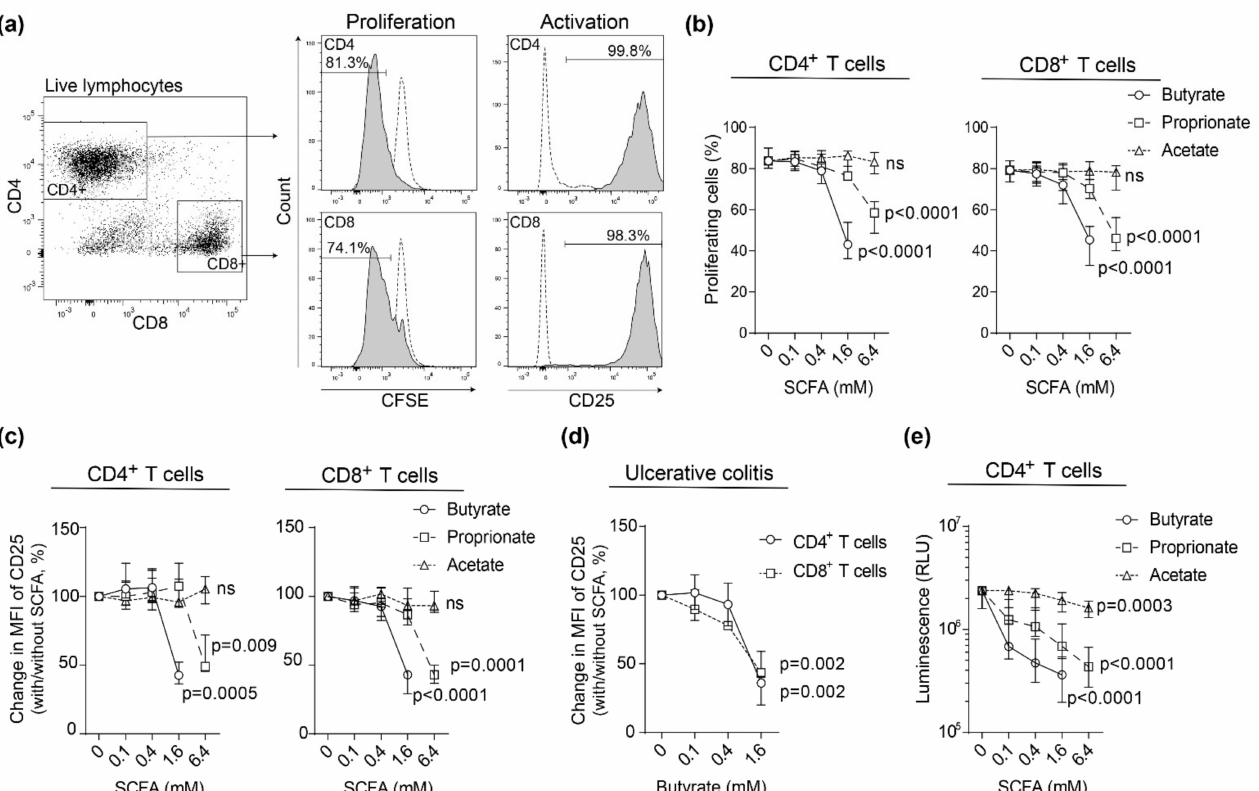
Figure 1. Effects of short-chain fatty acid (SCFA) on blood T cell proliferation and activation. Carboxyfluorescein succin- imidyl ester (CFSE) labeled peripheral blood mononuclear cells (PBMCs) were stimulated with anti-CD3 and anti-CD28 with increasing concentrations of butyrate (0–1.6 mM), proprionate (0–6.4 mM) or acetate (0–6.4 mM) for 72 h and analyzed by flow cytometry. ( a ) Left, gating strategy using a healthy subject for CD4 + and CD8 + T cells from live lymphocytes. Right, gating strategy for proliferating cells (CFSE intensity) and activated cells (CD25). Dotted line shows cells cultured without anti-CD3 and anti-CD28. ( b ) The frequency of proliferating T cells and ( c ) change in median fluorescent intensity (MFI) of CD25 in stimulated T cells from healthy subjects (n = 9). ( d ) Change in CD25 MFI in stimulated T cells from ulcerative colitis (UC) patients with active disease ( n = 7). ( e ) Histone deacetylase (HDAC) I and II activity in purified CD4 + T cells stimulated with anti-CD3 and anti-CD28 for 48h followed by addition of SCFAs at increasing doses for 1.5 h and subsequent HDAC-Glo TM I/II assay ( n = 6 healthy subjects). Data are shown as median and interquartile